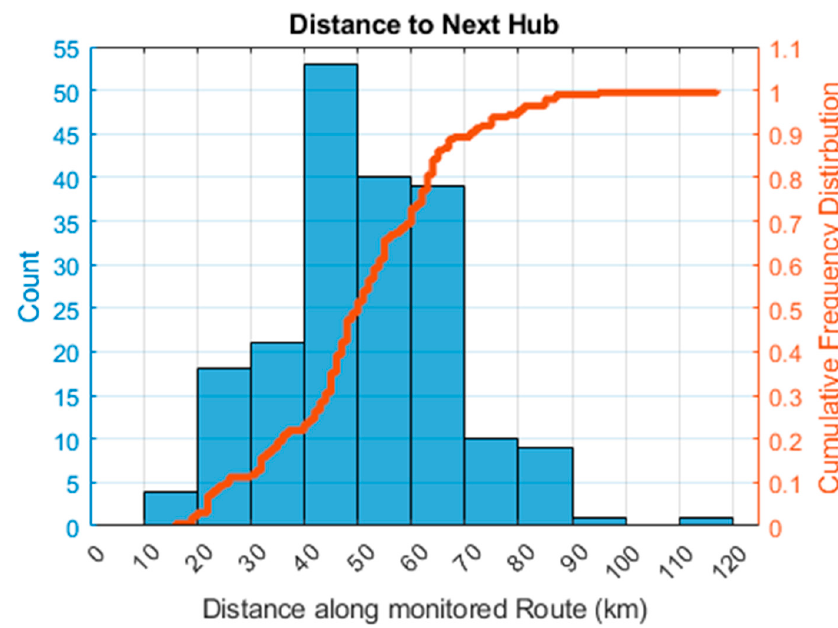
Figure 4. Distribution of inter-hub distances (on-road, not straight line).